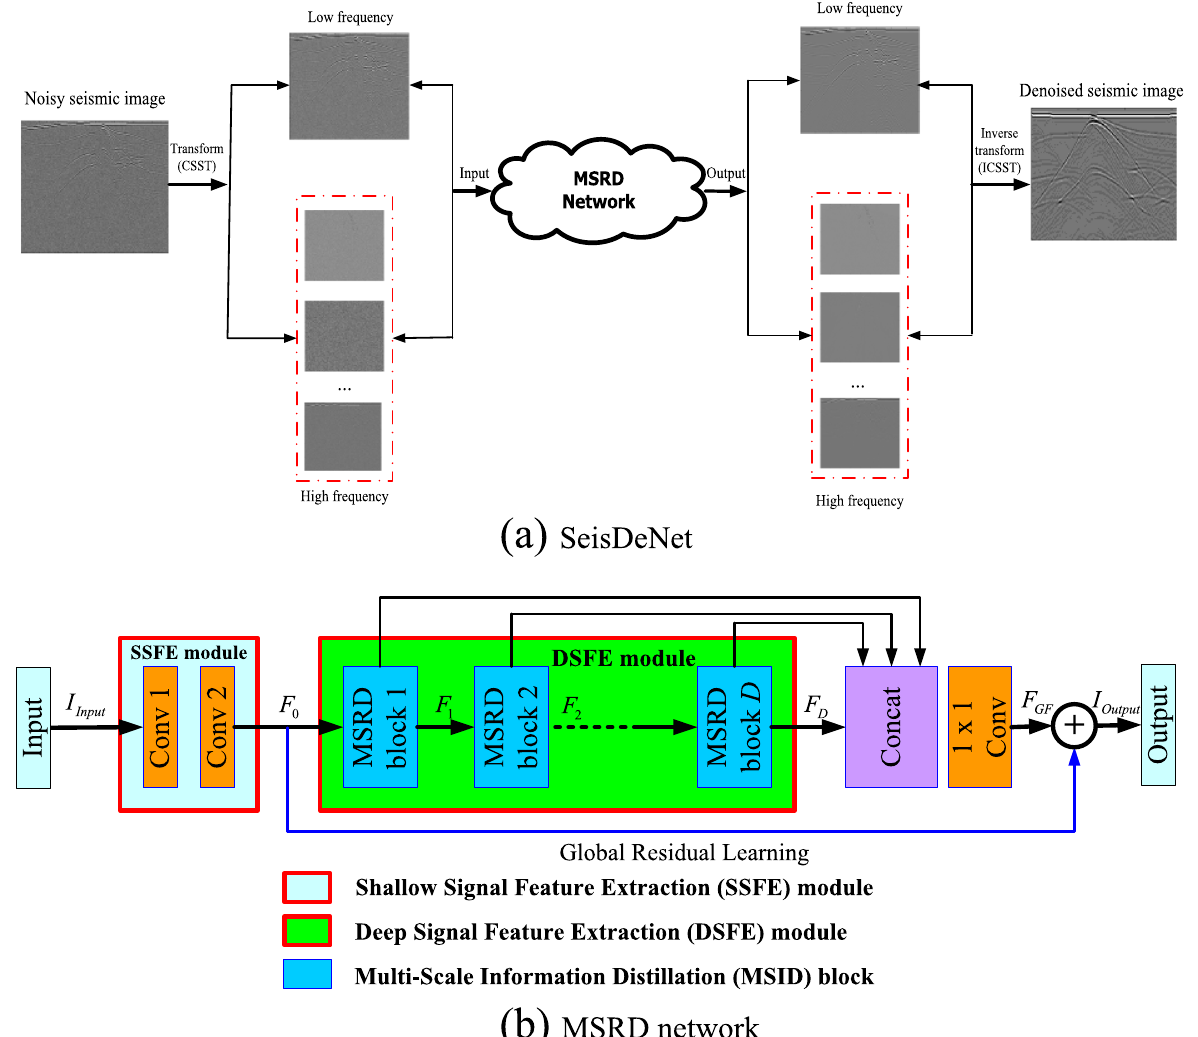
Fig. 1 SeisDeNet architecture. a Transform domain coefficients prediction with MSRD network; b The architecture of MSRD